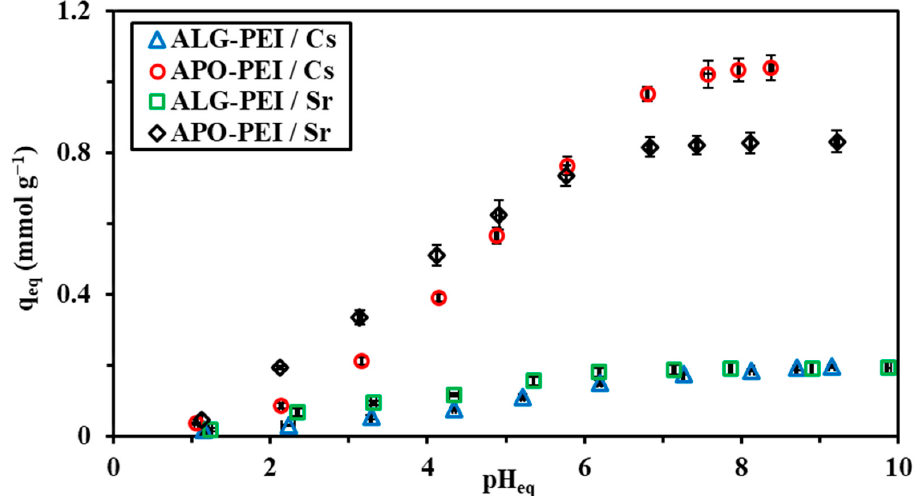
Figure 2. Effect of pH on Cs(I) and Sr(II) sorption using ALG-PEI and APO-PEI sorbents (C 0 : 0.802 mmol Cs L − 1 or 2.128 mmol Sr L − 1 ; sorbent dose, SD: 0.67 g L − 1 ; v: 210 rpm; time: 48 h; T: 21 ± 1 °C).